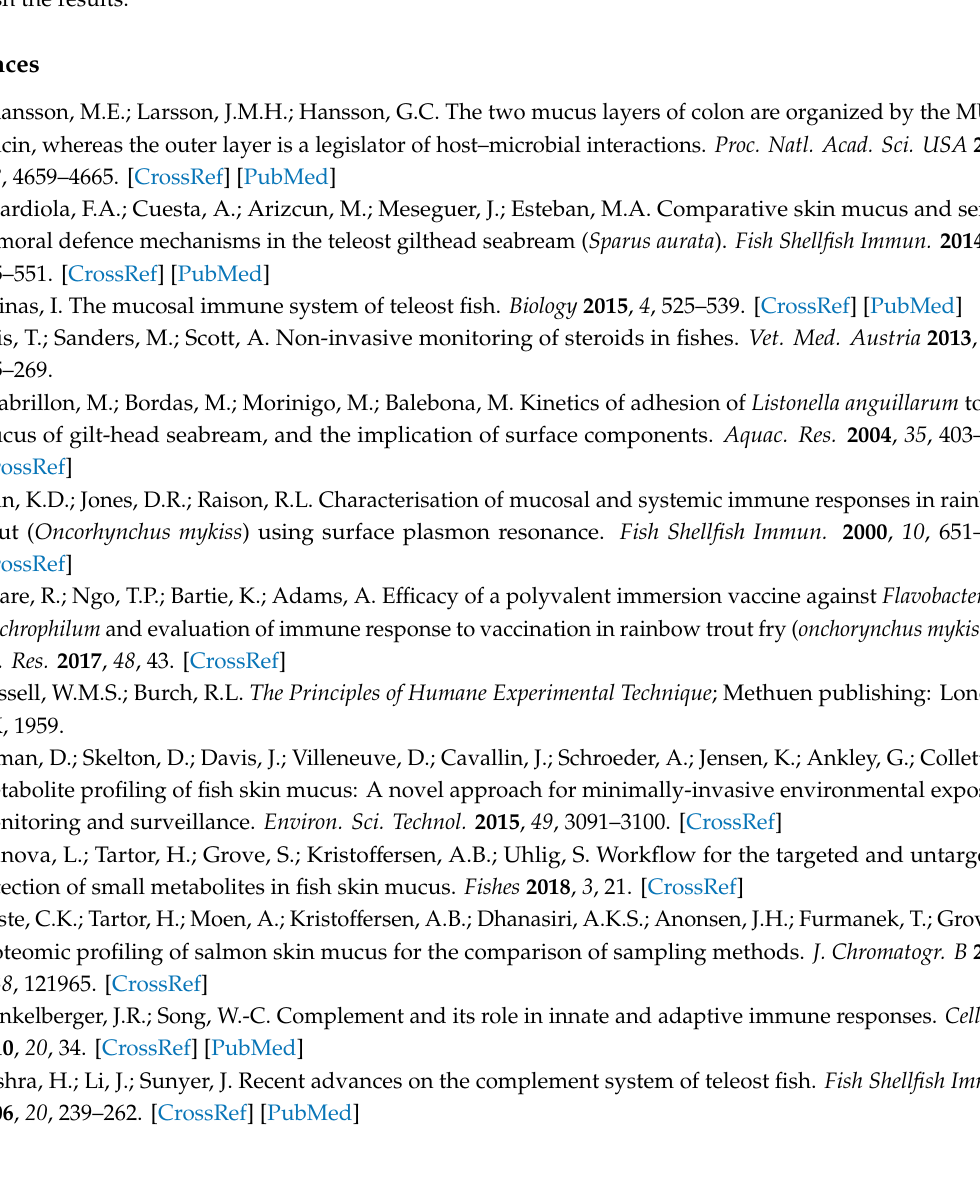
Figure S1: Scatter plots, including Kendall’s rank correlation analyses of A. salmonicida -specific IgM-A OD values between skin mucus samples collected by absorption, wiping and scraping, in a pairwise fashion from the same fish. Figure S2 : Specific immune responses against ALPHA JECT vaccination in fish absorbed gill mucus and